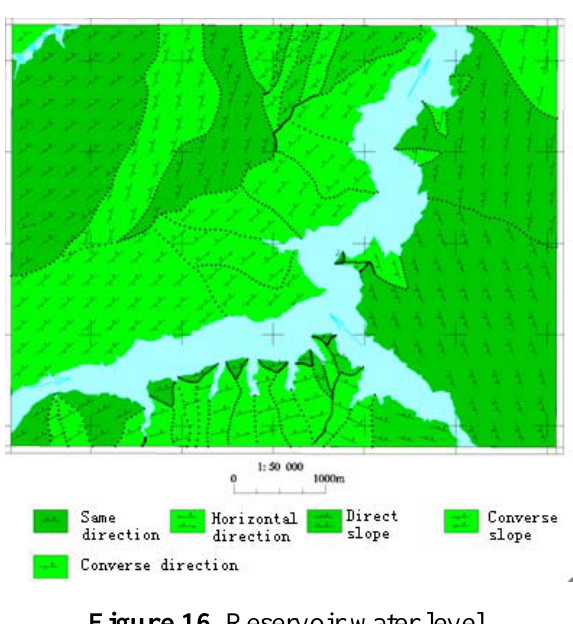
Figure 16. Reservoir water level.